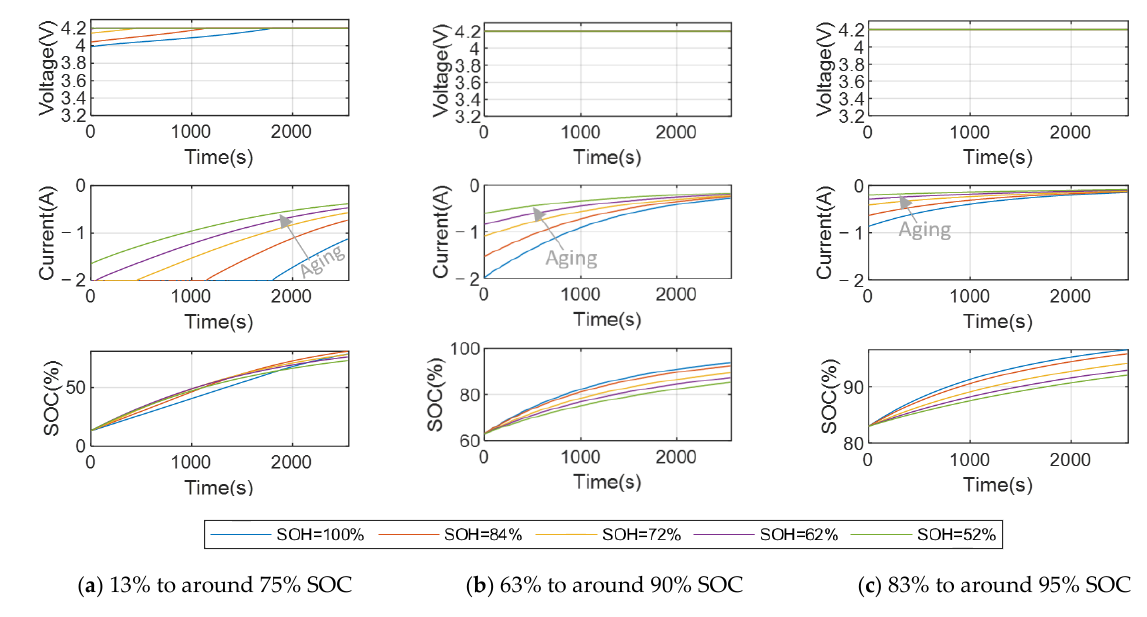
Figure 10. Examples of voltage, current, and SOC time domain charging measurements used for training SOH algorithm. Each set of partial SOC charge data is 2560 s long, the input data length for the CNN.